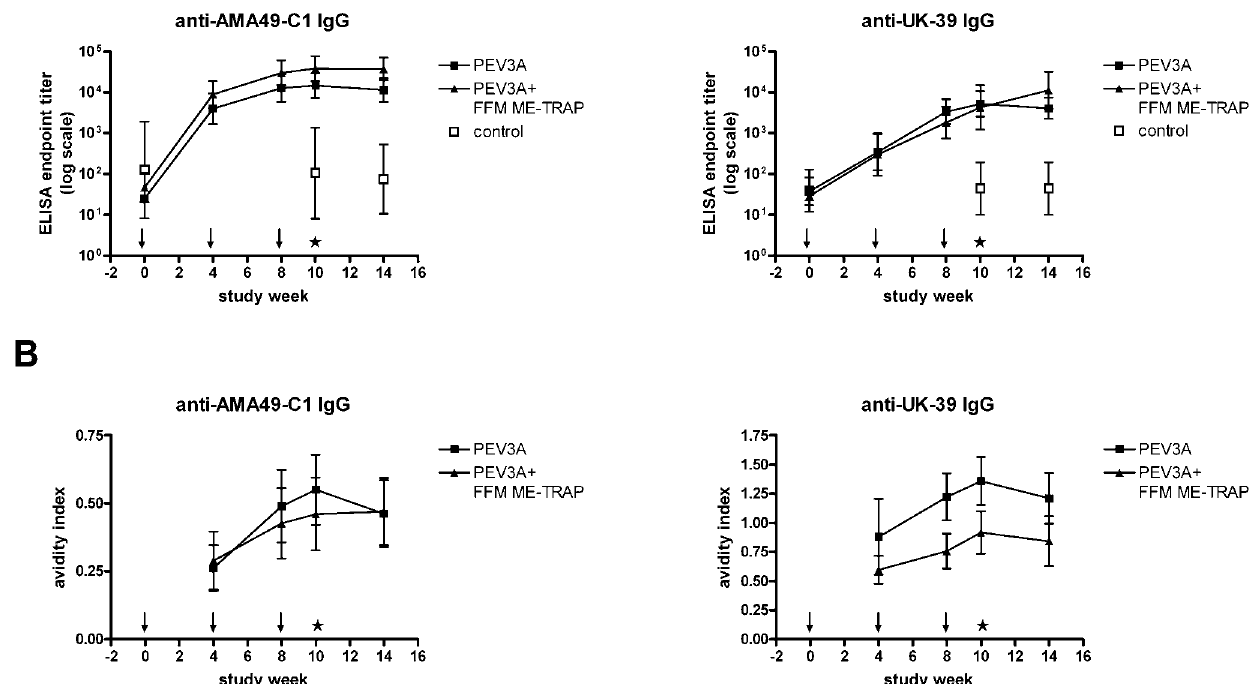
Figure 3. Anti-peptide responses. A. (Upper panel) Geometric mean anti-AMA49-C1 (PEV301) and anti UK-39 (PEV302) endpoint-titres (log10) with 95% confidence intervals for group 1 (PEV3A), group 2 (PEV3A + ME-TRAP) and unvaccinated controls. B. (Lower panel) Mean avidity increase (relative to avidity index after first immunisation) with 95% confidence intervals. Arrows along the x axis represent the timing of each vaccination, and the asterisk denotes the